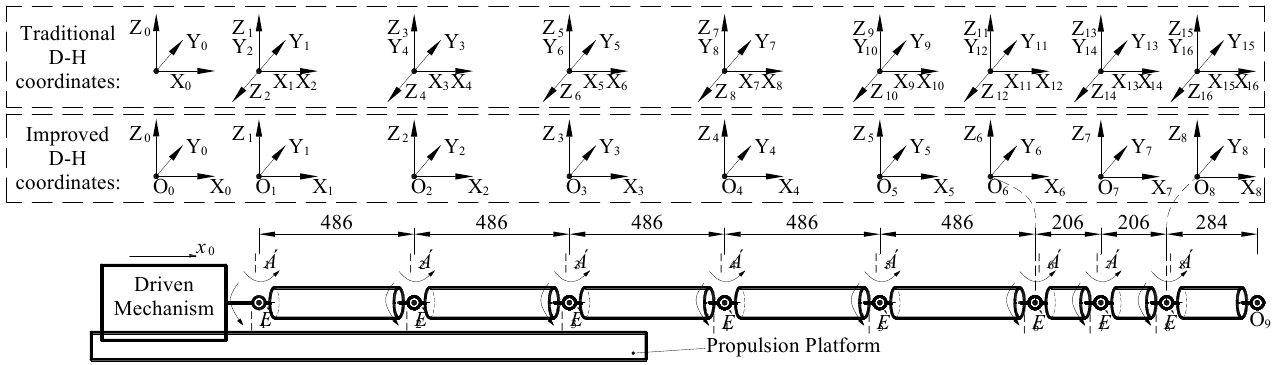
tem are shown in Figure 1. The entirety of the manipulator possesses a translational free- dom X 0 in one direction along with the propulsion platform. The manipulator is composed of eight serial links with a total of 16 rotational degrees of freedom, and each link has two degrees of freedom: pitch angle θ i and yaw angle α i . Each link is driven by three cables, and the position of each cable is driven by each motor. In total, 24 cables are driven by 24 motors, controlling 16 rotational degrees of freedom of the eight links.